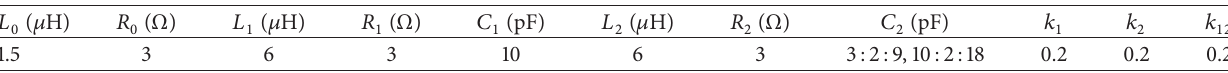
Table 3: 𝐶 2 change from 3pF to 9pF.